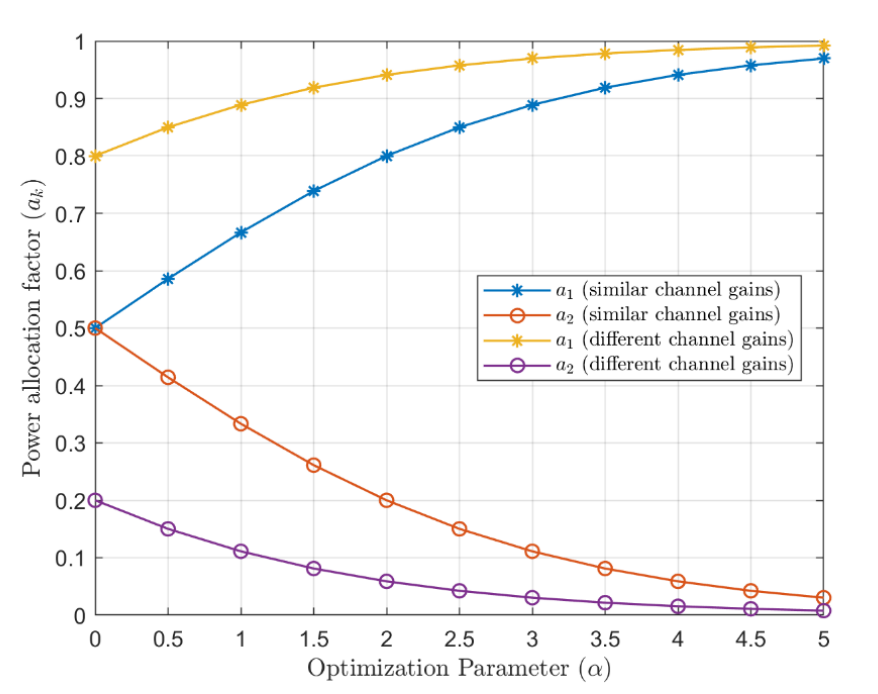
Figure 7. PA coefficients using DOPA with the optimization